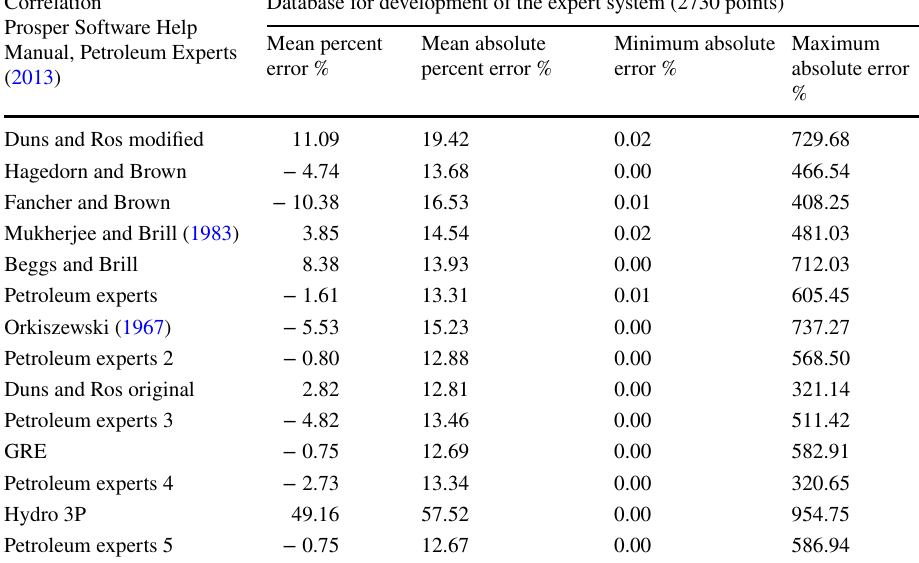
Table 2 Average error and average absolute error of the different fourteen correlations for the entire database